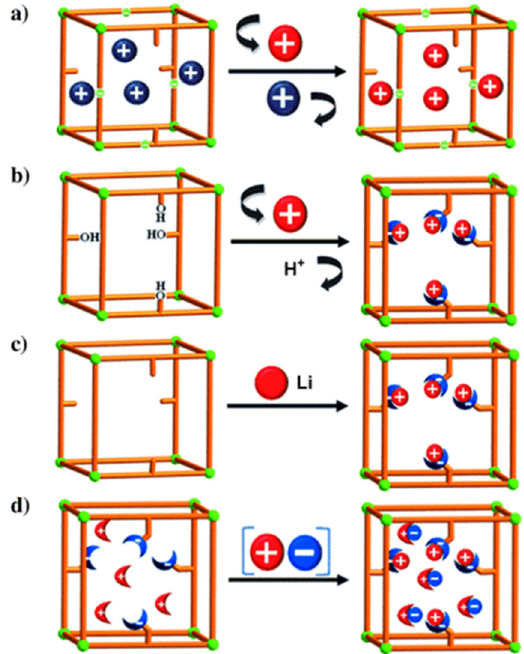
Figure 5. Three basic ways of introduction of open metal sites by PSM synthetic routes to MOFs: ( a ) cationic guests or organic cations exchange (blue balls) with metal cations (red balls); ( b ) replacement of a hydroxy protons with Li + and Mg 2+ ions (red balls); ( c ) chemical reduction of MOM with Li (red balls) and ( d ) fourth method is a combination of the first two—a collaborative attachment of metal (red balls) chloride (blue ones) salts to anion and cation binding sites. Besides, the sticks and the crescent-shaped bowls attached to sticks are porphyrin-encapsulated inside MOM-11 and cation/anion binding sites. Reprinted with permission from [50].